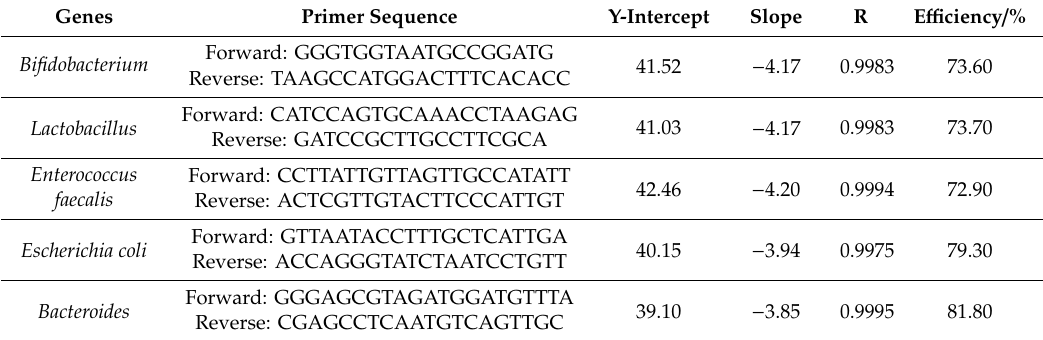
Table 2. Primer pairs used to analyze gene expression and the amplification e ffi ciencies by